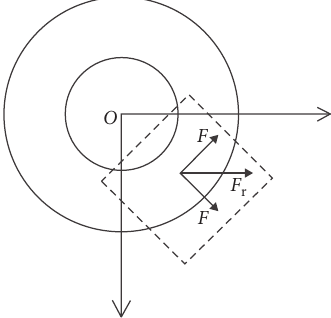
Figure 2: Structure and shear deformation of the lead core. F : the shear force of the lead core, H : the total height of the lead core, H thickness of the upper and lower steel plates, 2 H s : the thickness of the middle steel plate, h : the calculated height of the yield displacement of the lead core, c : the shear strain, Δ : the shear displacement, D : the diameter of the lead core.